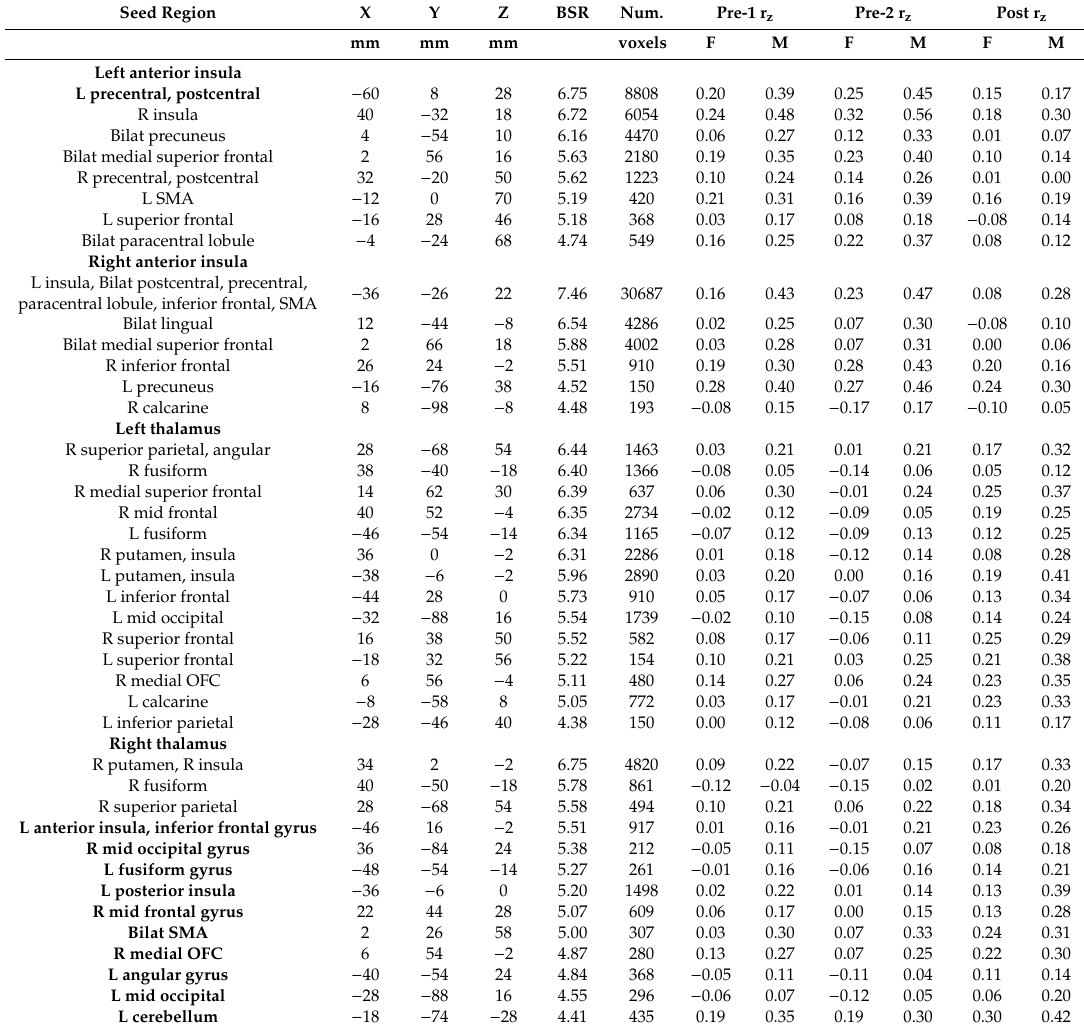
Table 1. Regions of interest (ROI) connectivity a ff ected by meal